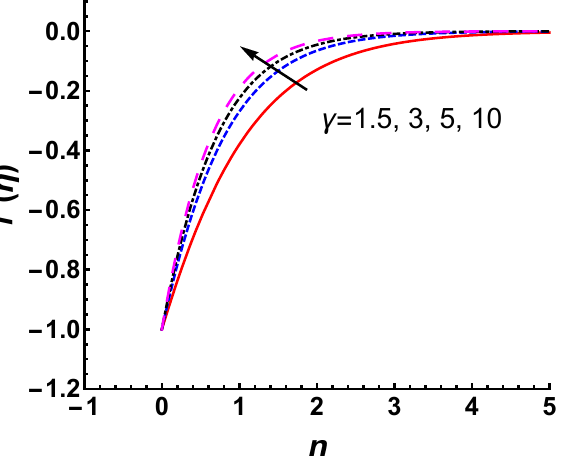
Figure 5. Velocity profile for different values of γ with Pr = 0.71, M = 1 and s = 2.